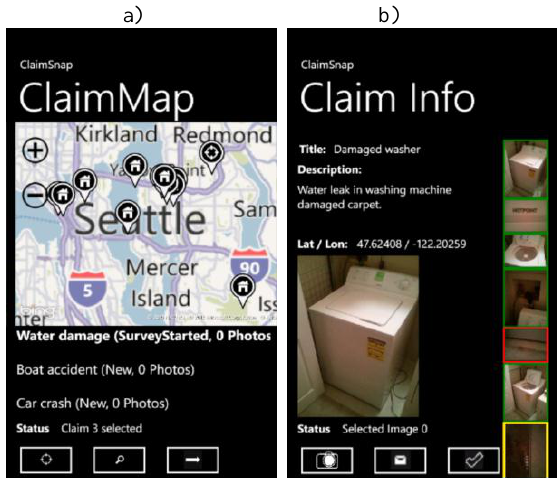
Figure 11 Graphical User Interface (GUI) for Windows Phone™ Client a) ClaimMap page showing an overview of different claims; b) Claim Info page showing details for